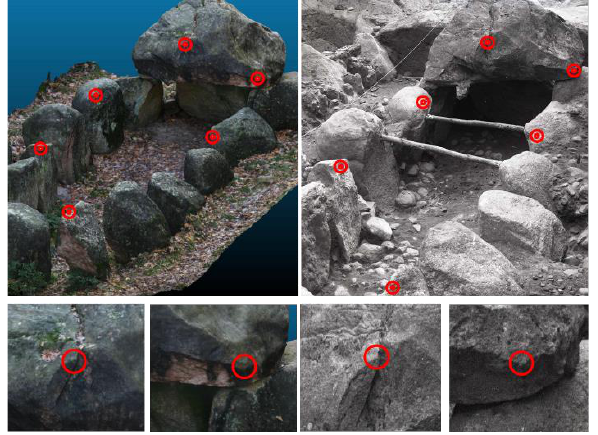
Figure 10: Corresponding points between the current model (left) and the historical image (right).